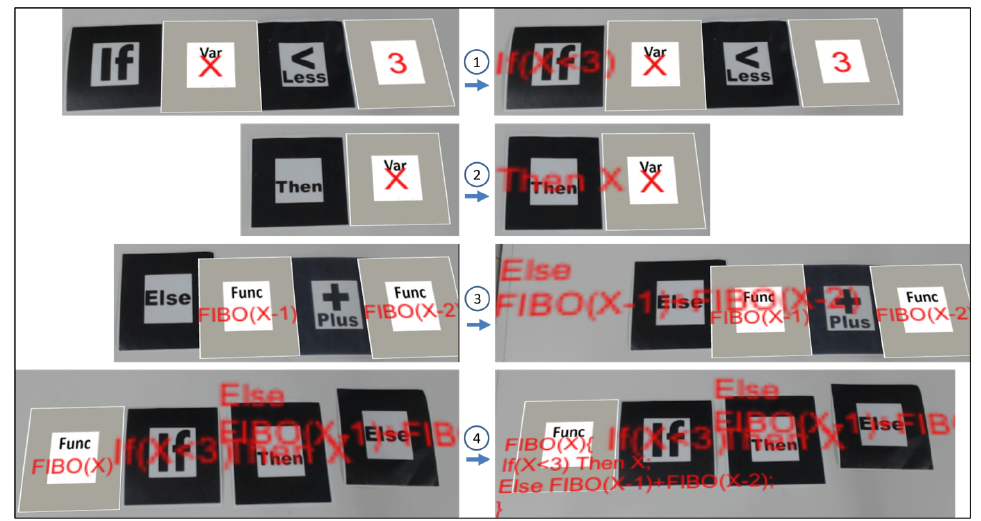
Figure 7. An example of Fibonacci function definition using virtual and physical markers. In steps 1, 2, and 3, the user arranges the virtual and physical markers in order and merges the combined information into the first physical marker (If, Then, and Else markers) through a defining gesture. When the combined information is added to the physical markers, the combined information will be superimposed and displayed on the physical markers in the form of AR. In step 4, the user arranges the function virtual marker and the defined If, Then, and Else physical markers in order and merges the combined information into the function virtual marker through a defining gesture to complete the function definition. The function marker has already been defined and can be used for further